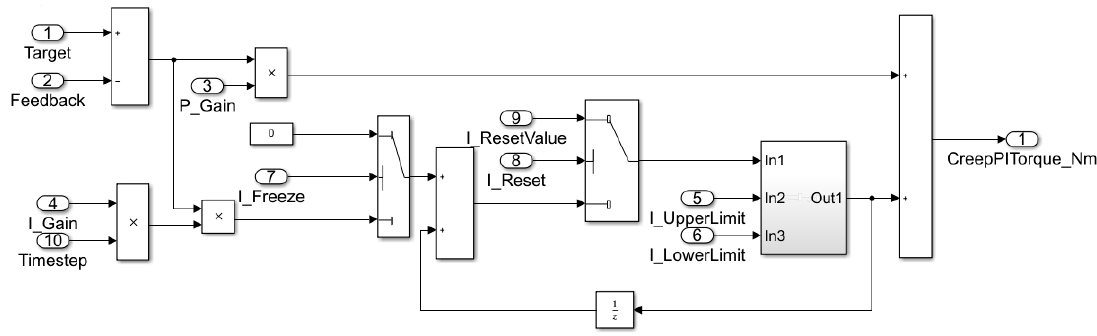
Figure 10. Pedal Control Torque Calculation Module.